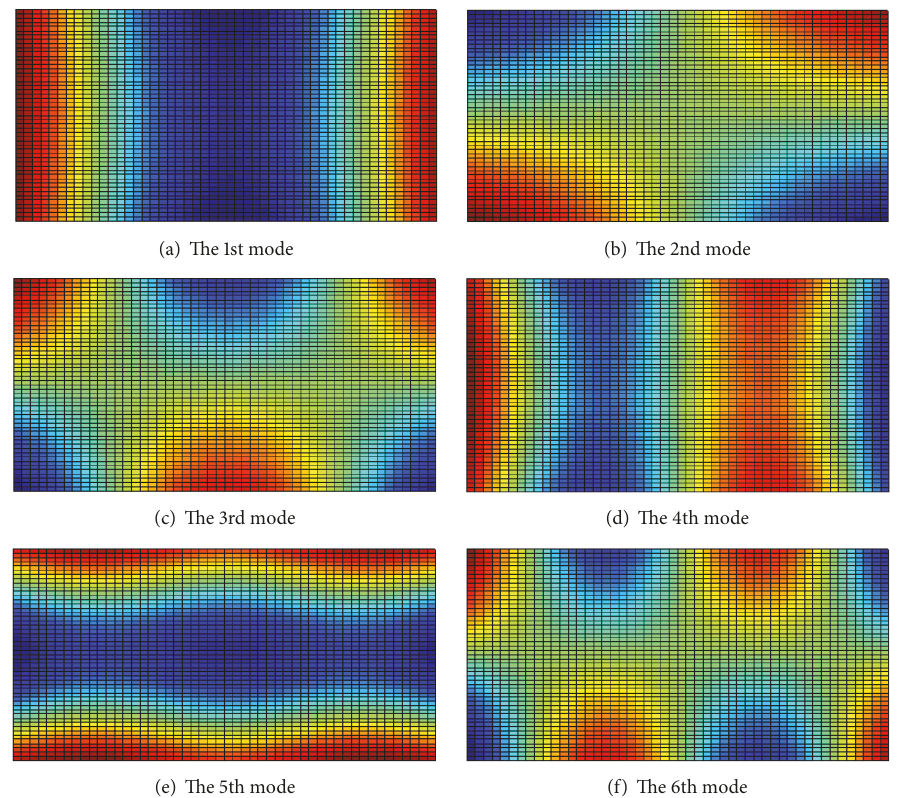
Figure8:Thefirstsixmodeshapesofrectangularplateswithcompletelyelasticboundaryconditionsandtheaspectratioas 𝑎/𝑏 = 2 , ℎ/𝑏 = 0.1 , 𝜉 = 𝜉 = 10 8 , and 𝜉 = 0 , calculated by the present 𝑘 𝑖 𝐾 𝑖 𝐾 𝑖𝑗